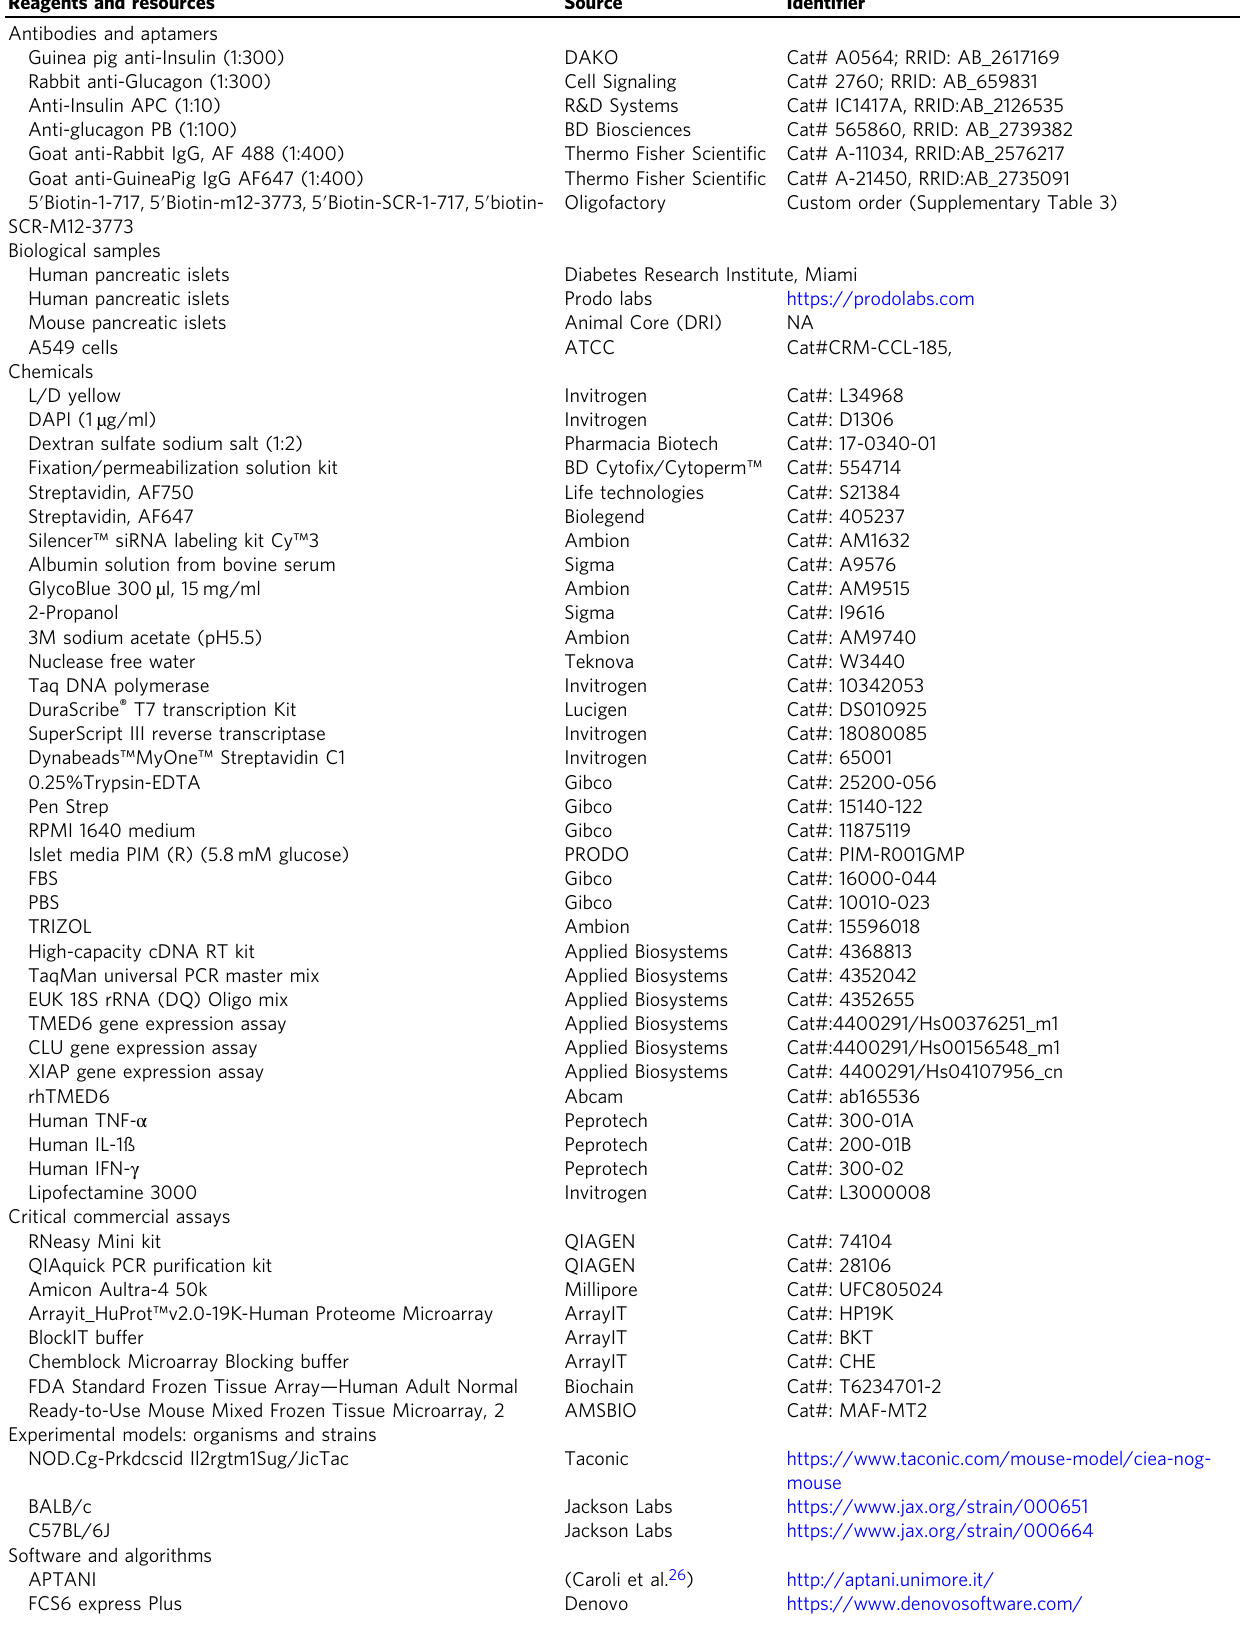
Table 1 List of key resources used in the